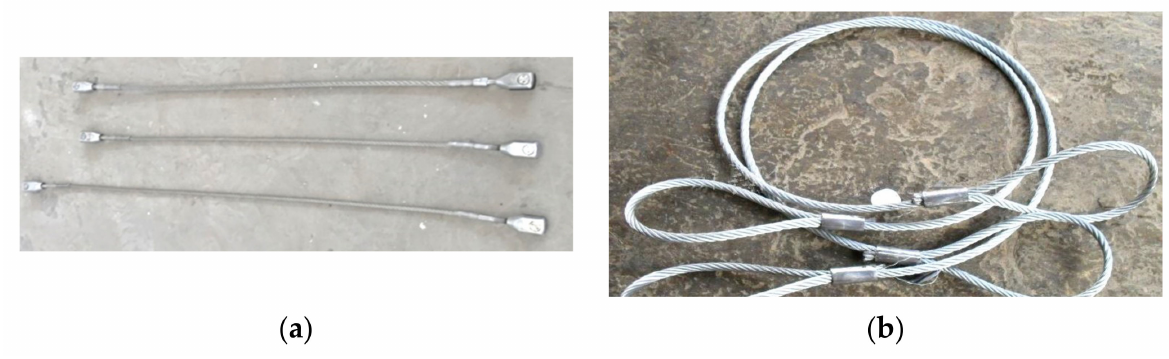
Figure 7. Photographs of the cables. ( a ) OC; ( b ) RC.